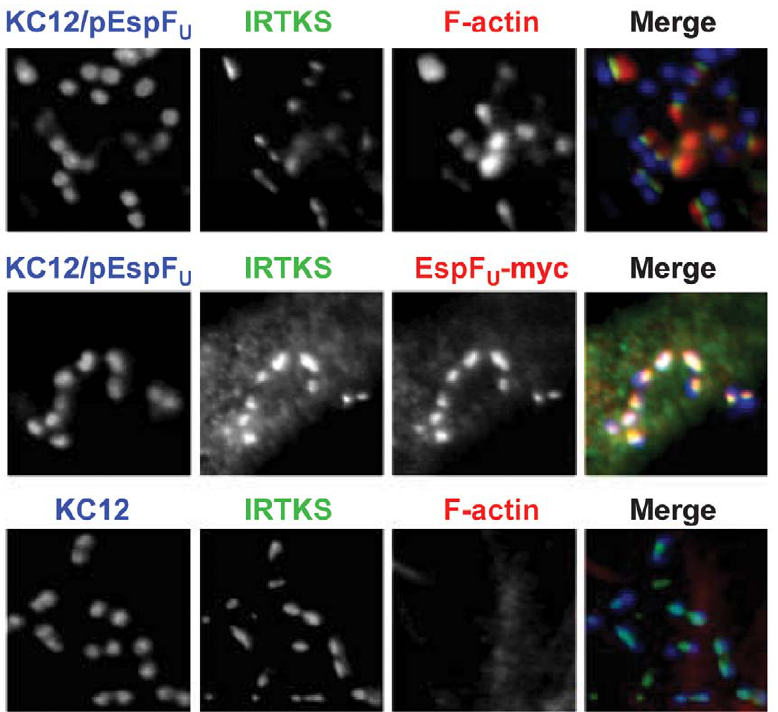
Figure 4. The Tir-EspF U linker protein IRTKS localizes to bacteria even in the absence of N-WASP. NW 2 / 2 FLCs were infected with KC12/ pEspF U or KC12, and examined after staining with DAPI to detect bacteria, anti-IRTKS antibody (green) and Alexa568-phalloidin to detect F-actin (red). To detect EspF U -myc, monolayers were treated with rabbit anti-myc antibody and Alexa568-conjugated anti-rabbit antibody (red, middle